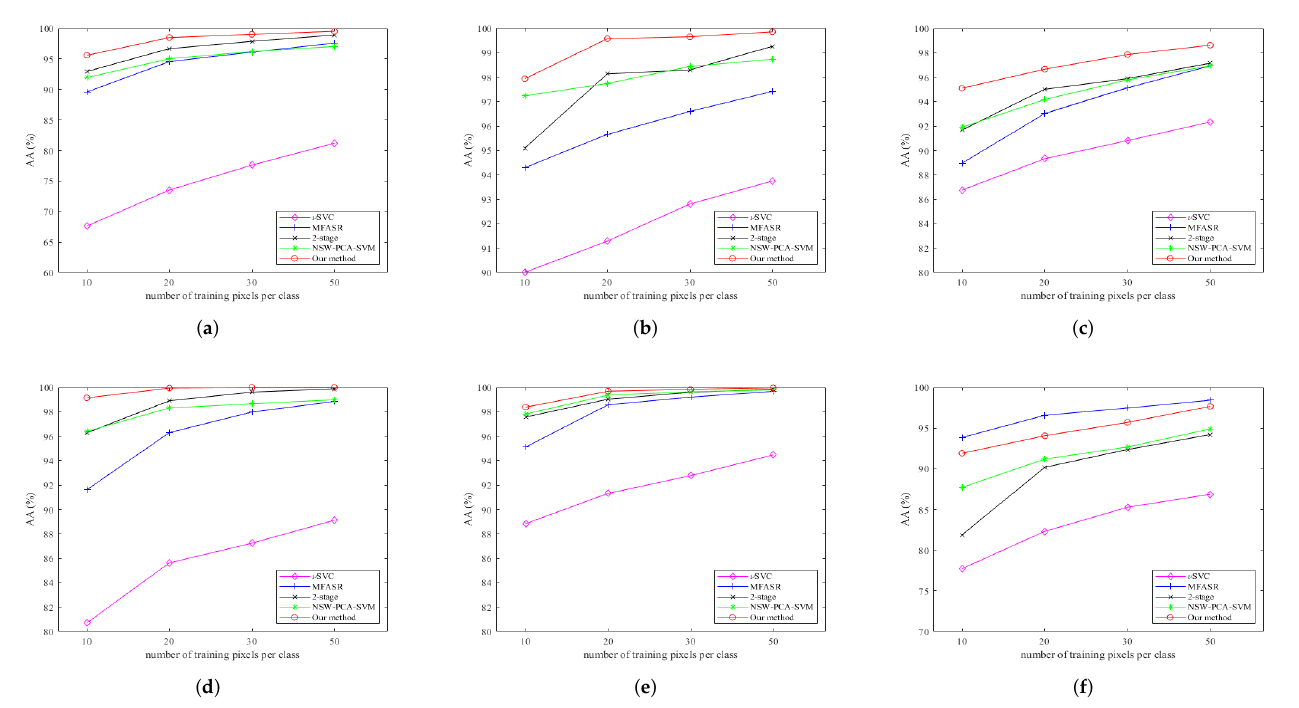
Figure 7. AAs ( y -axis) for different datasets with a different number of training pixels ( x -axis). ( a ) AA on the Indian Pines dataset; ( b ) AA on the Salinas dataset; ( c ) AA on the Pavia Center dataset;